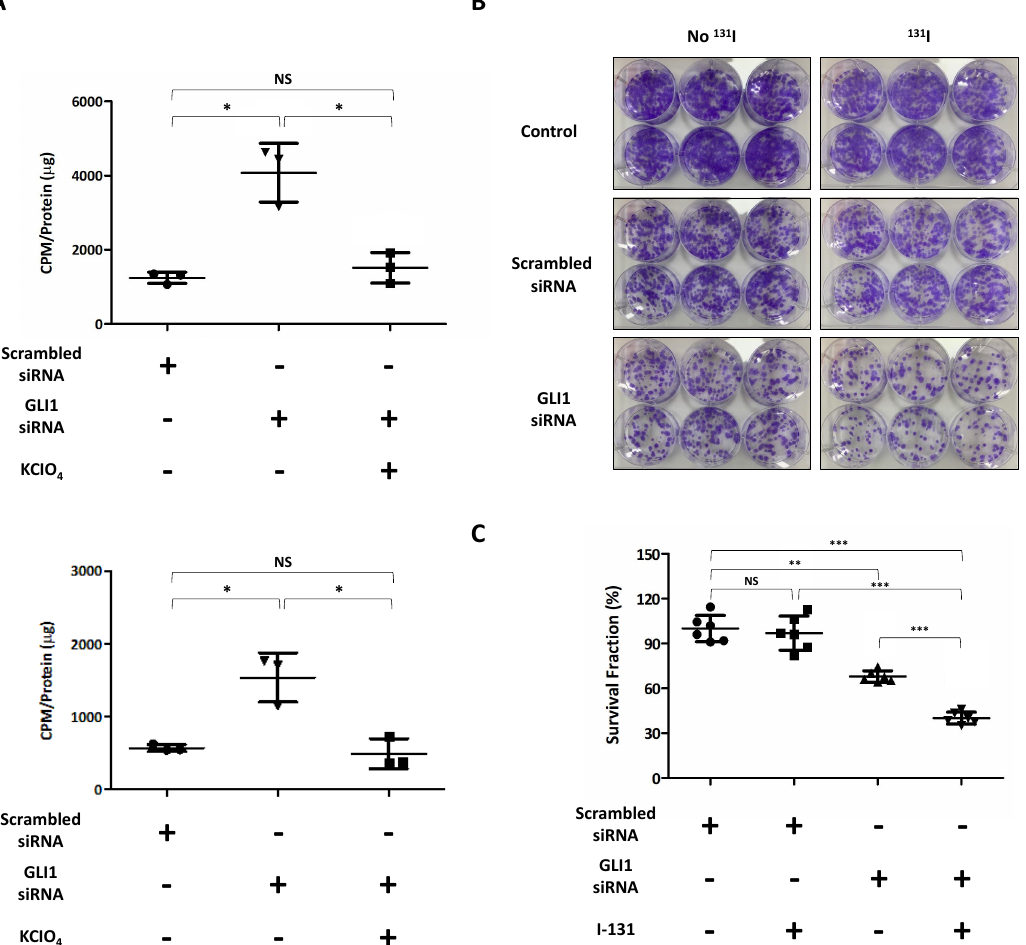
Figure 4. Verification of the extent of I-125 accumulation and I-131-mediated cytotoxic effect in GLI1-inhibited thyroid cancer cells. Both TPC-1 and SW1736 cells were treated with scrambled siRNA or GLI1 siRNA for 48 h. ( A ) For I-125 uptake assay, cells were treated with 37 kBq carrier-free I-125 and 100 µ M sodium iodide at 37 ◦ C for 30 min. Potassium perchlorate (KCIO 4 ) was used as a competitive inhibitor of iodide transport. Upper–TPC-1 cells; Lower–SW1736 cells. The results are expressed as mean ± SD values of the experiment performed in triplicates. * p < 0.05, NS: Not Significant (by Student’s t -test). ( B ) After incubation of siRNA in TPC-1 cells, the cells were incubated with or without 50 µ Ci/ml I-131 supplemented with 30 µ M NaI for 7 h at 37 ◦ C. Images about I-131 clonogenic assay. ( C ) Quantitative analysis based on I-131 clonogenic assay. The results are expressed as mean ± SD values of the experiment performed in triplicates. *** p < 0.001, ** p < 0.01, NS: Not Significant (by Student’s t